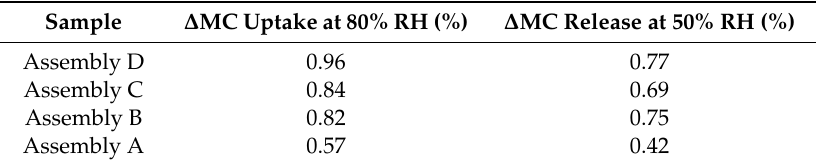
Figure 3. Sorption / desorption kinetics at 80% and 50% RH. Table 2. Variation in moisture uptake and